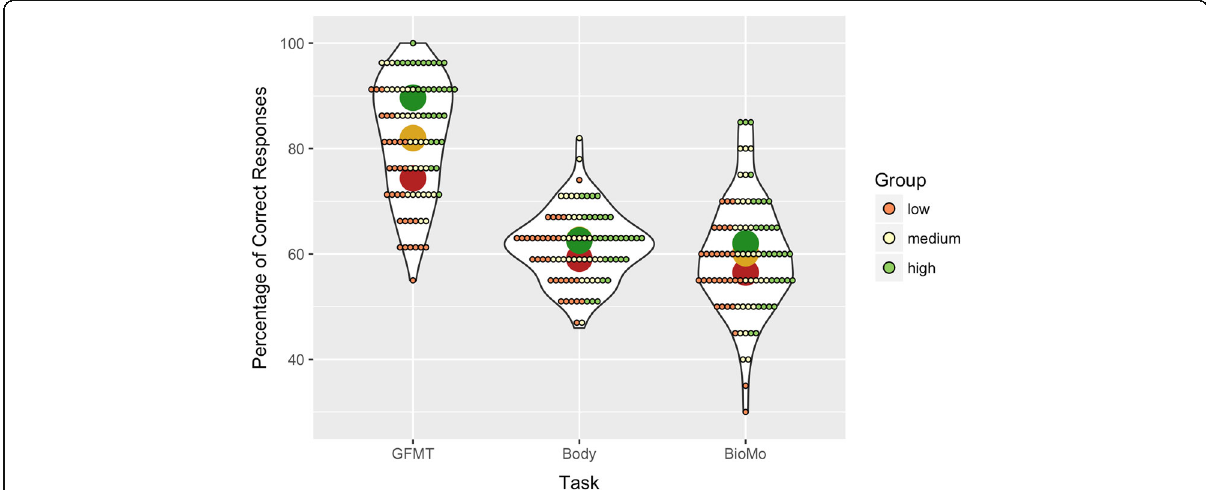
Fig. 3 Violin plots show performance accuracy of each participant (small circles) colour coded by their Expertise in Facial Comparison Test (EFCT) ability score (low, red; medium, yellow; high, green) for tasks Glasgow Face Matching test (GFMT) (Face), Body and BioMo (Biological Motion). Task is on the x axis, and accuracy (% correct) is on the y axis. For each task, mean performance in each face-recognition-ability group (low, red; medium, yellow; high, green) is depicted by a large coloured